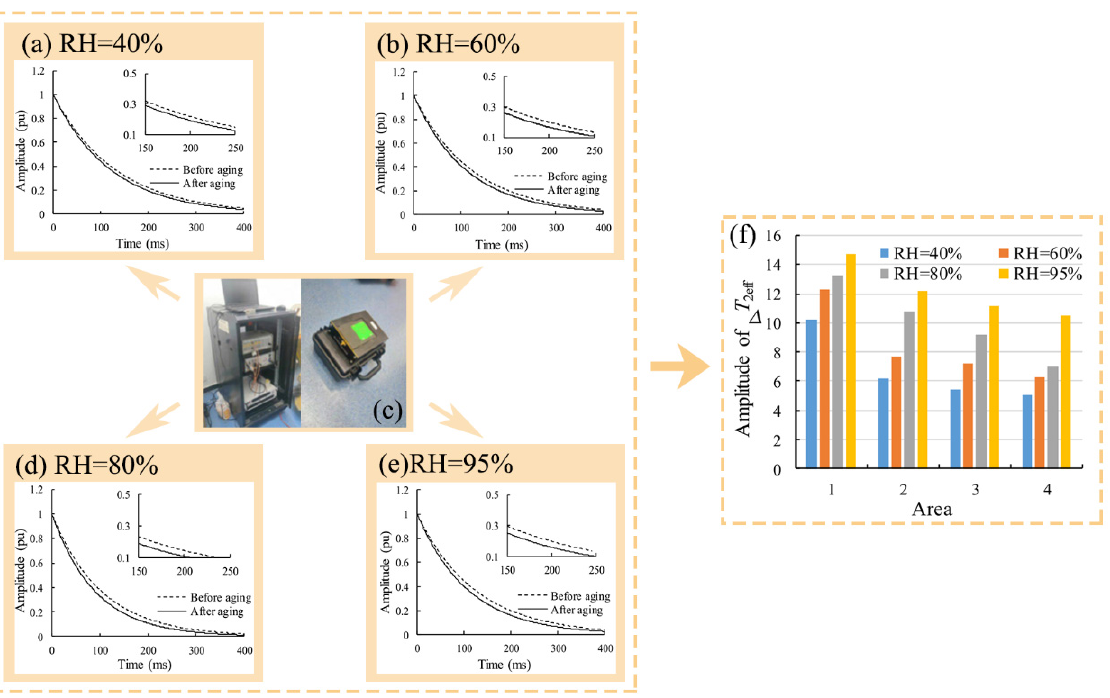
Figure 9. Detection of composite insulators by NMR. ( c ) NMR detection equipment. ( a , b , d , e ) NMR curves at different humidity levels. ( f ) T 2eff values for four different areas and different humidity levels.